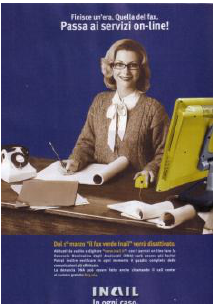
Figure A10. Own selected picture, “ordinary woman”.